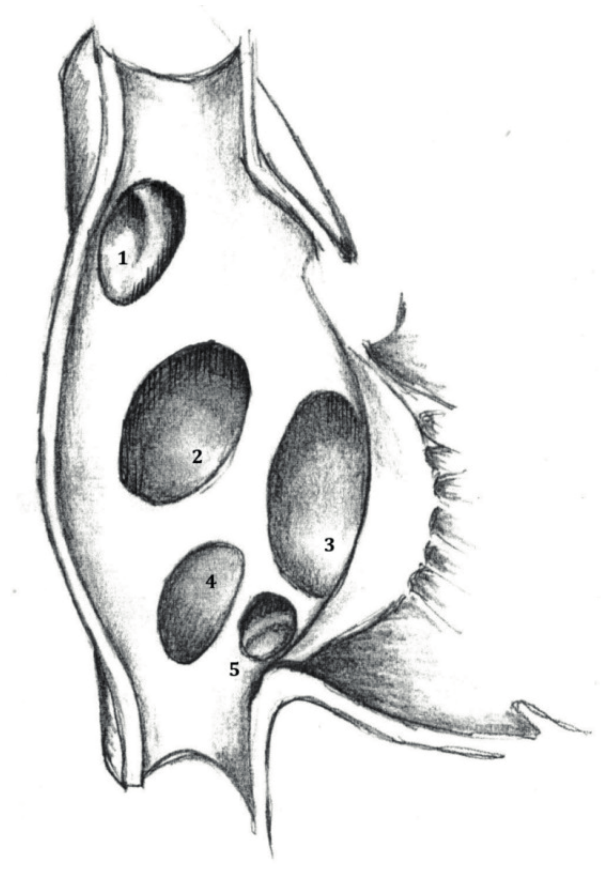
Fig. 4. Schematic illustration of the interatrial defects and their share in the total number of atrial septal defects in